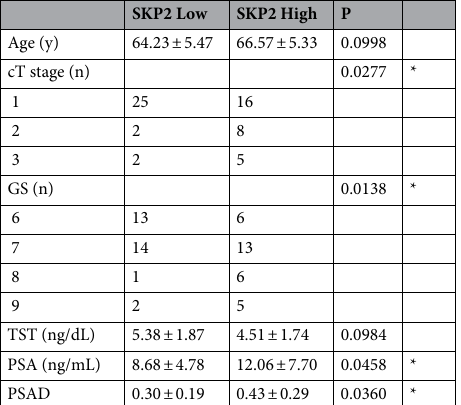
SKP2 Low SKP2 High P Age (y) 64.23 ± 5.47 66.57 ± 5.33